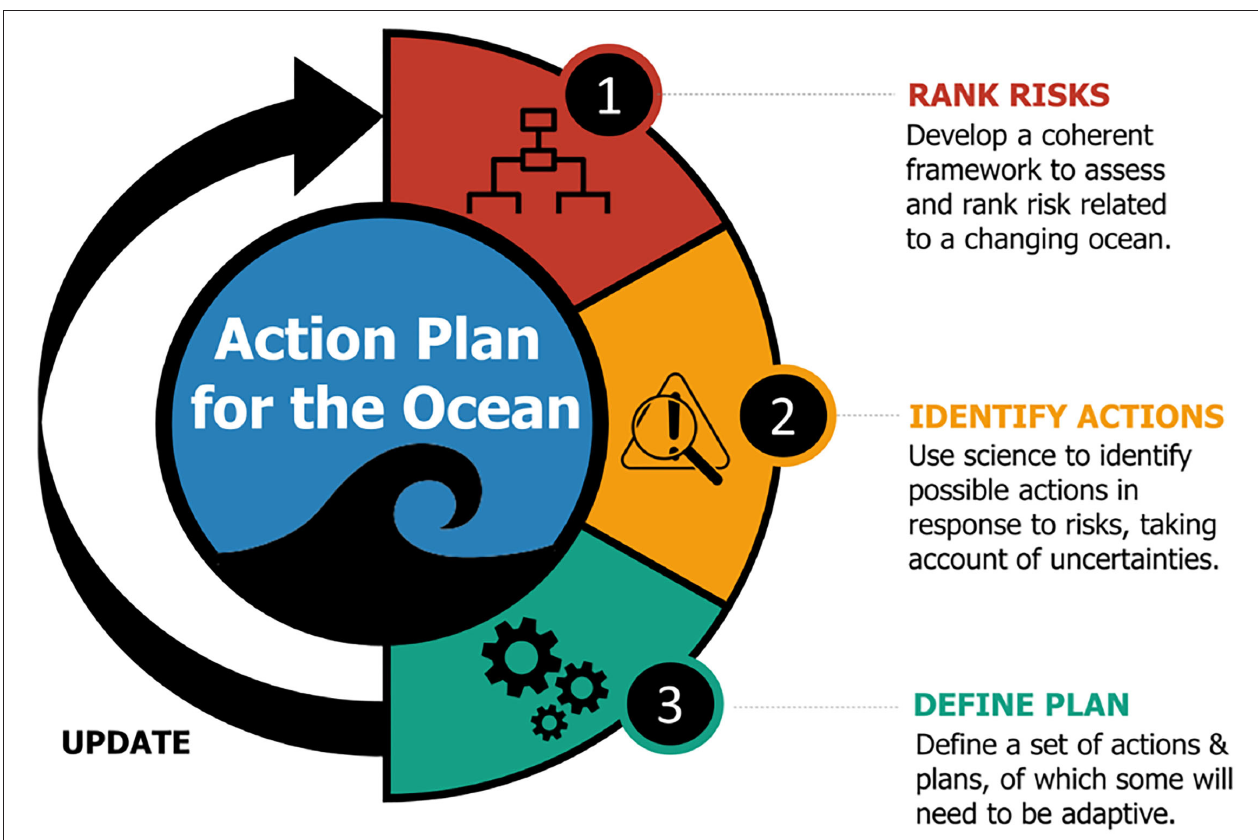
FIGURE 1 | Schematic illustrating the main elements of an Action Plan for the Ocean .